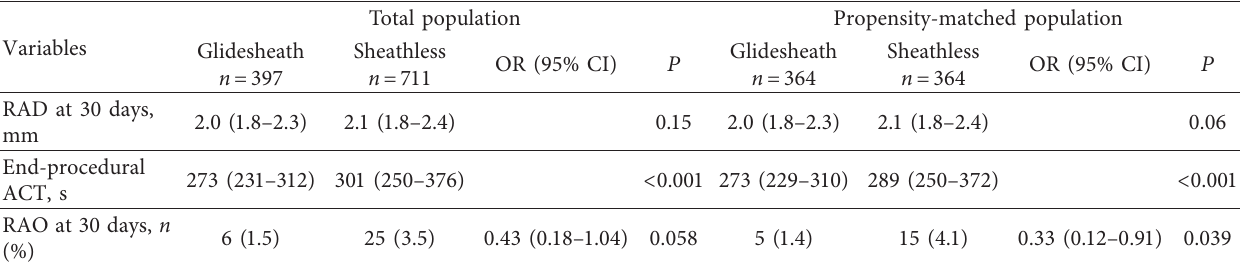
Table 4: Periprocedural access-site